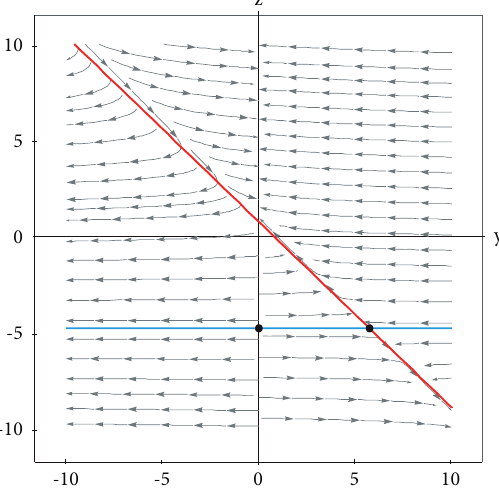
Figure 9: Phase plane of system (9) for ρ vector field and some trajectories are indicated by lines and arrows in gray. Two nullclines are shown: one horizontal (blue line) and other vertical (red line); the horizontal and vertical remaining pair coincides with the z -axis. The disease-free equilibrium point E unstable, and the endemic E ∗ ≃ ( 5 . 733 , − 4 . 733 ) is a saddle point; both points are indicated by a black